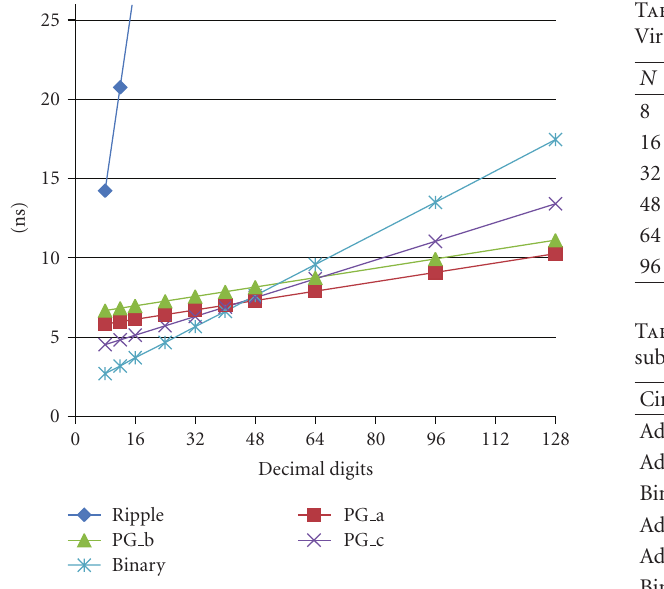
Figure 18: Delay in ns for di ff erent adders in Virtex-4.